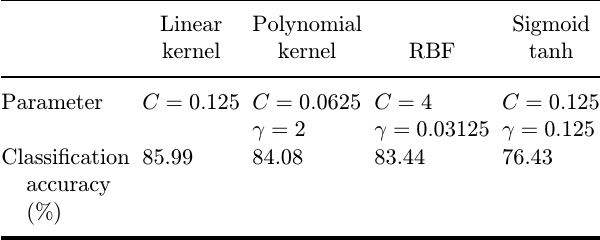
Table 1. Optimal parameters of four di®erent kernels.